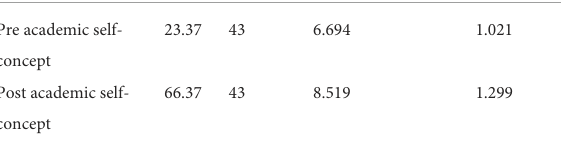
TABLE 5 Mean and standard deviation of pre- and post-academic self-concept. Mean N Std. Deviation Std. Error